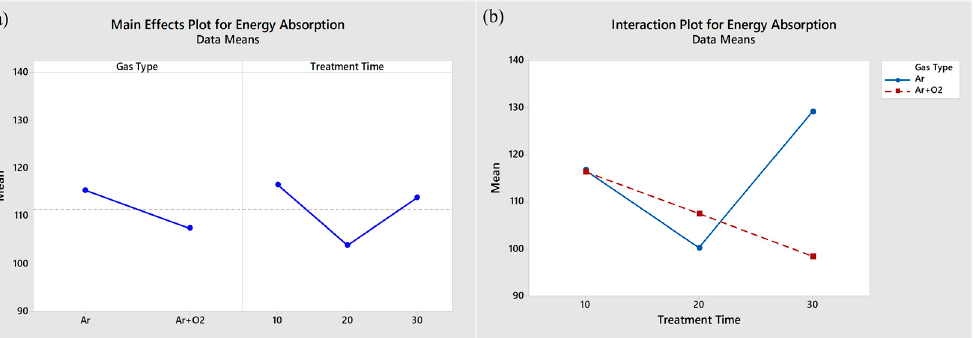
Figure 12. Main e ff ect and interaction plot for the EA capacity for plasma-treated bamboo fi - Figure 12. Main effect and interaction plot for the EA capacity for plasma-treated bamboo fiber/epoxy ber/epoxy matrix composites. matrix